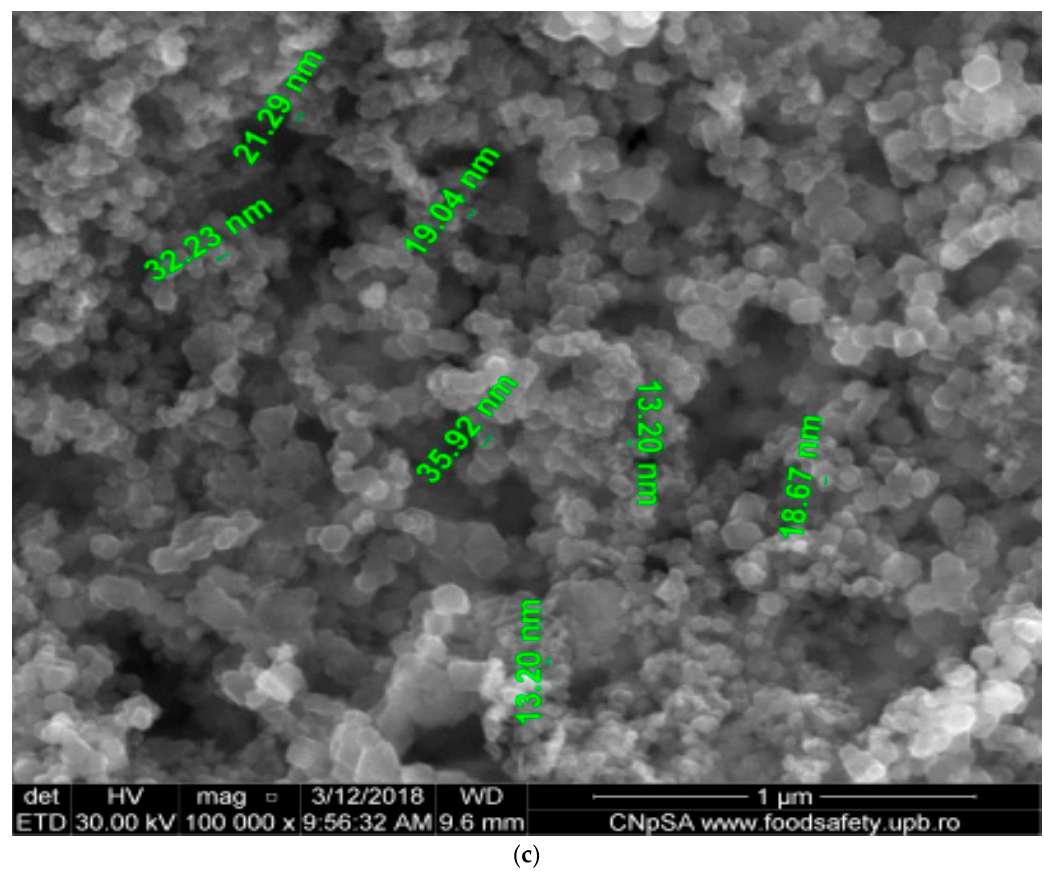
Figure 3. SEM images. ( a ) NP 1 morphologies ( b ) NP 2 morphologies ; ( c ) NP 3 morphologies. [AgCl 2 ] − shorthand notation NP 1